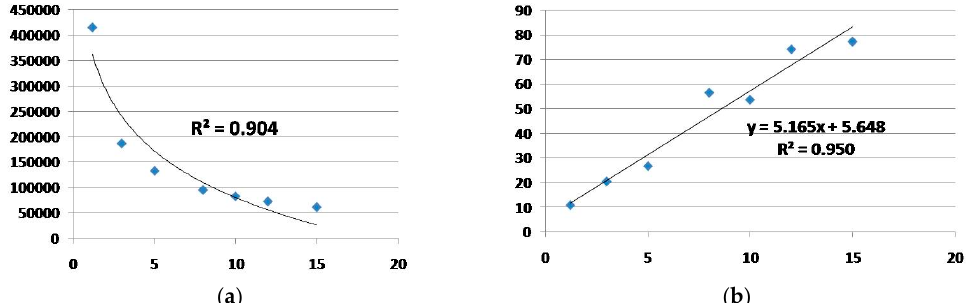
Figure 9. ( a ) The relationship between the total length of the extracted boundaries and the spatial resolutions, ( b ) A linear relationship between the median widths of extracted yardangs using different spatial resolutions.